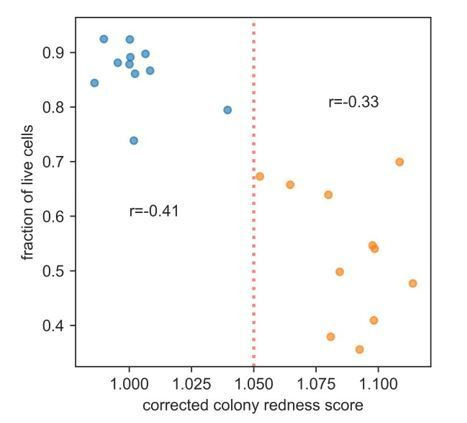
Subgroup analysis of colony staining.We divided the data into two groups and computed the correlation separately. Both groups still show clear correlation (0.41 and -0.33) which is incompatible with the claim that the method allows a binary classification only. However, the within-group correlation is substantially lower than the overall correlation. Regardless, redness scores in themselves are highly reproducible and precise and therefore present an attractive fitness readout, the use of which does not require a detailed mechanistic understanding.